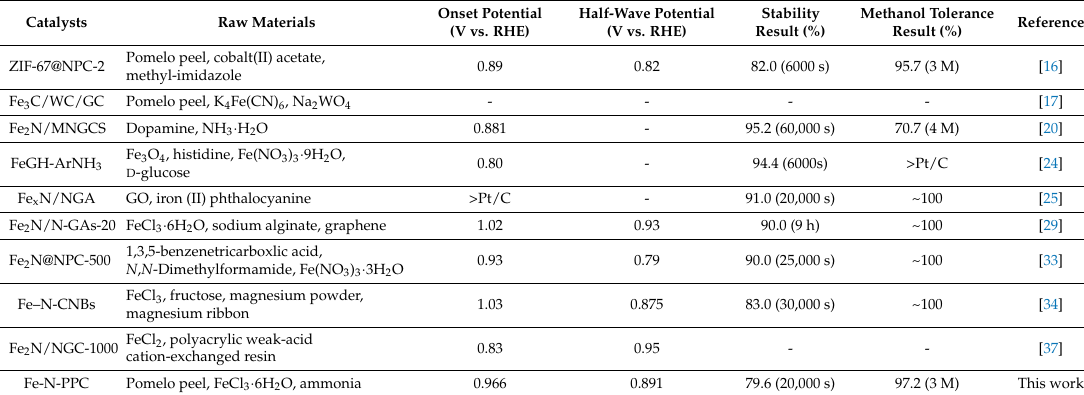
Table 4. Comparation of Fe-N-PC with Fe 2 N/C catalysts and pomelo peel-derived carbon materials for oxygen reduction reaction (ORR) reported recently. In the table, reversible hydrogen electrode was abbreviated as RHE. GO stands for graphene